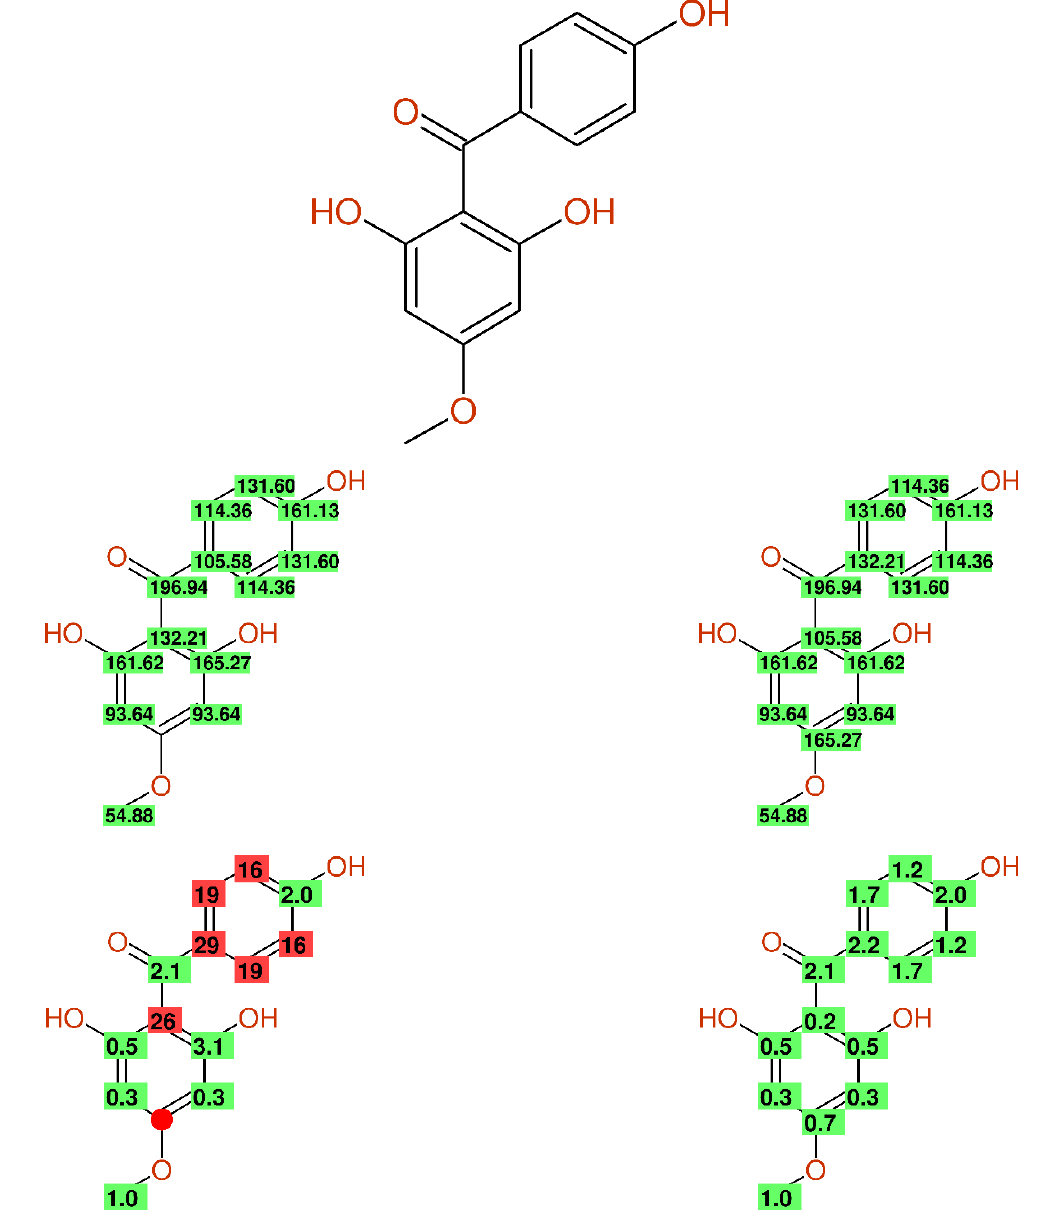
Figure 11. 13 C-NMR data of a benzophenone-derivate (already corrected with respect to the erroneously drawn hydroxy- group in position 2) taken from [55], as published ( left ) and the corrected version ( right ).